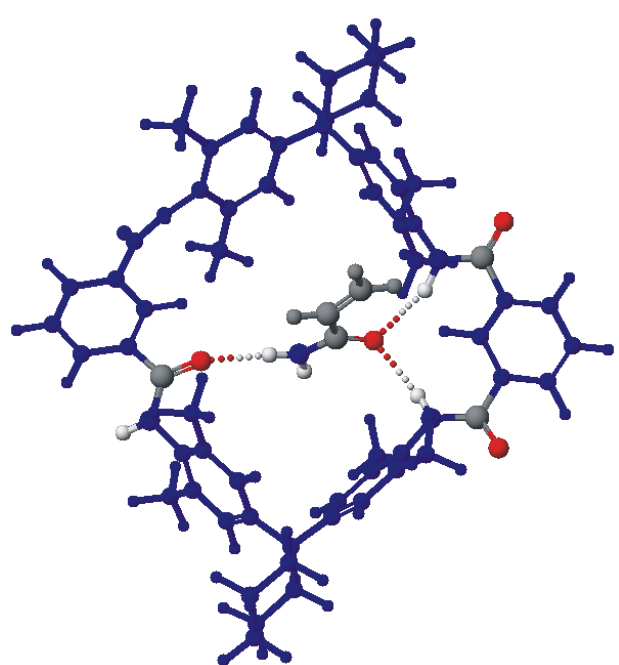
Figure 9. AM1-optimized structure of the complex of tetralactam macrocycle 5 with